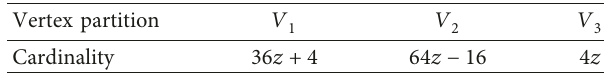
Table 3: The partition of the vertex set of ( TM − TCNB ) 1 .